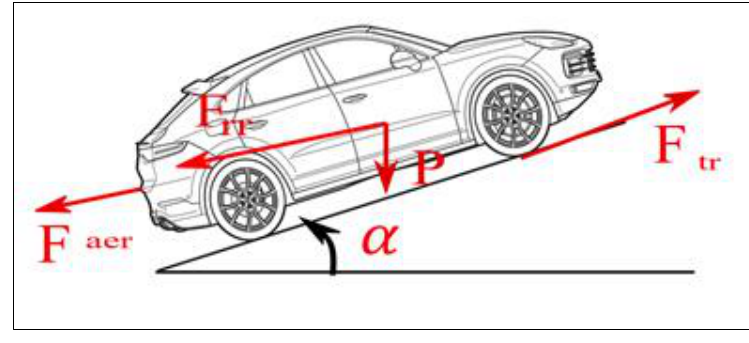
Figure 3. Forces applied to a